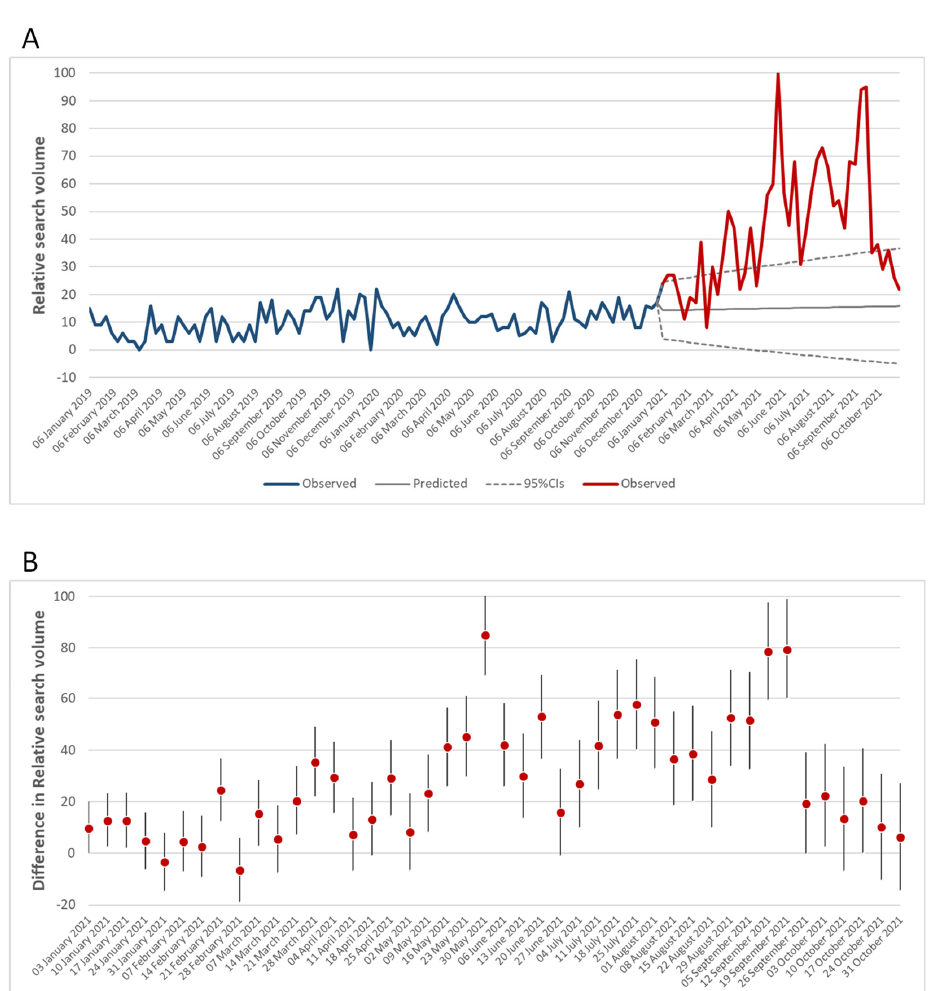
Figure 5. Search interest for the keyword “Vaccine in pregnancy” (Search term) before and after the introduction of COVID-19 vaccination. ( A ) Comparison between observed and predicted values of the search interest for the keyword “Vaccine in pregnancy”; ( B ) differences between weekly observed and predicted values.